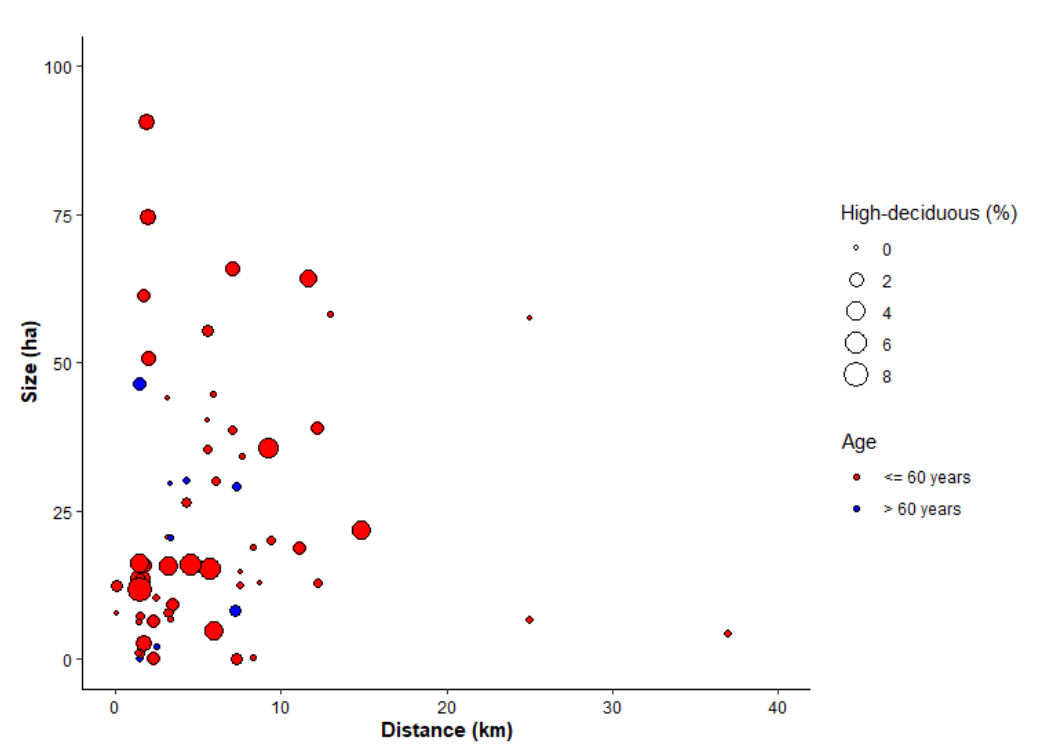
Figure 7. Scatterplot showing, for each restored site, the size, distance to the nearest other restored site, and the percentage of the site, including its buffer (representing 500 ha), containing high-deciduous forest before restoration. Blue dots indicate sites whose trees were, on average, older than 60 years. Red dots represent younger sites.